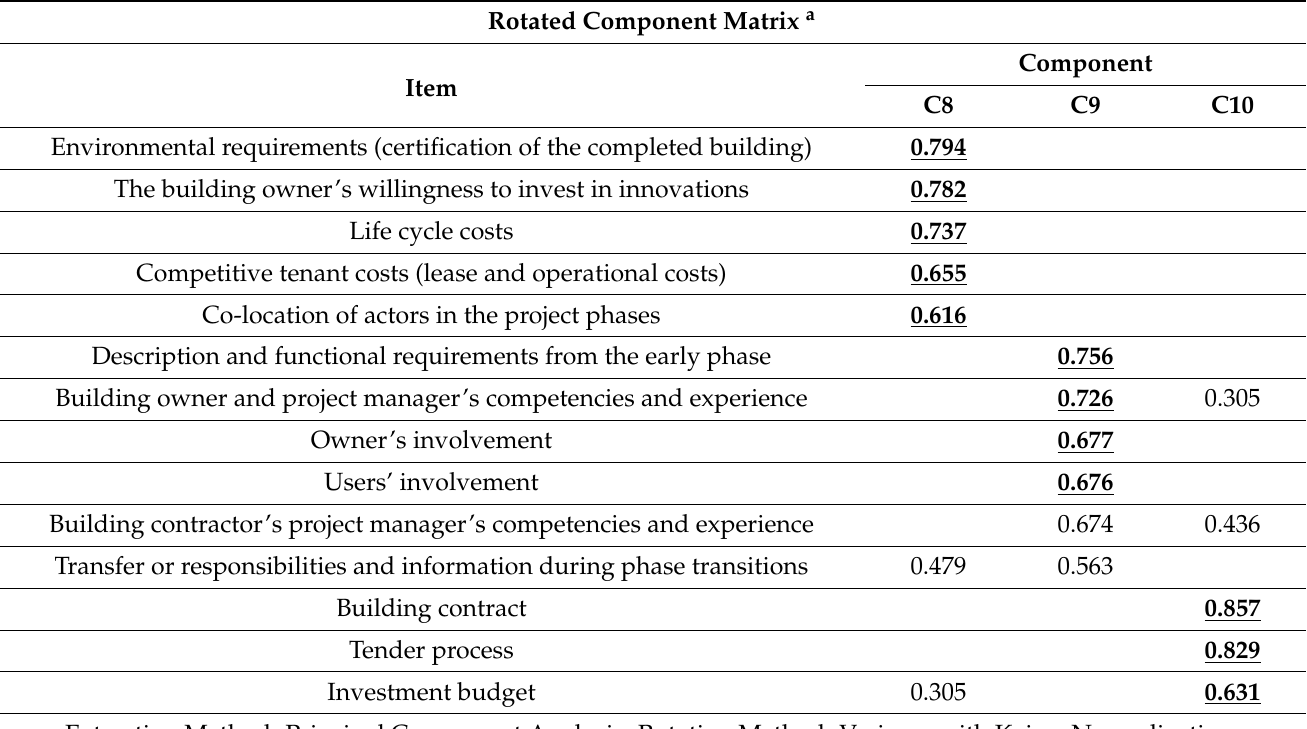
Table 5. Rotated component matrix—Success factors and obstacles concerning attainment of the building owners’ and the users’